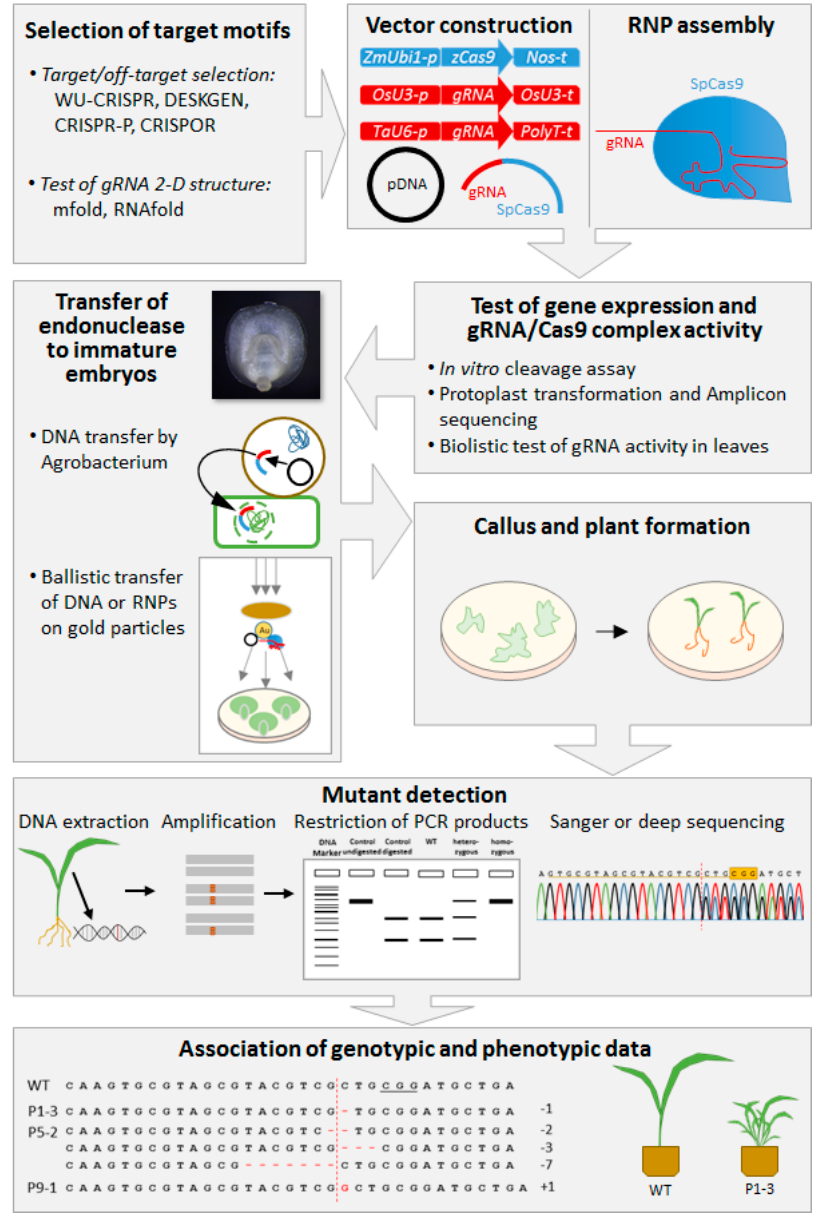
Figure 1. General workflow of targeted genome modification in barley and wheat, including target motif selection, vector construction, vector tests, gRNA and Cas9 delivery, plant regeneration, mutant detection, and genotypic and phenotypic analyses.